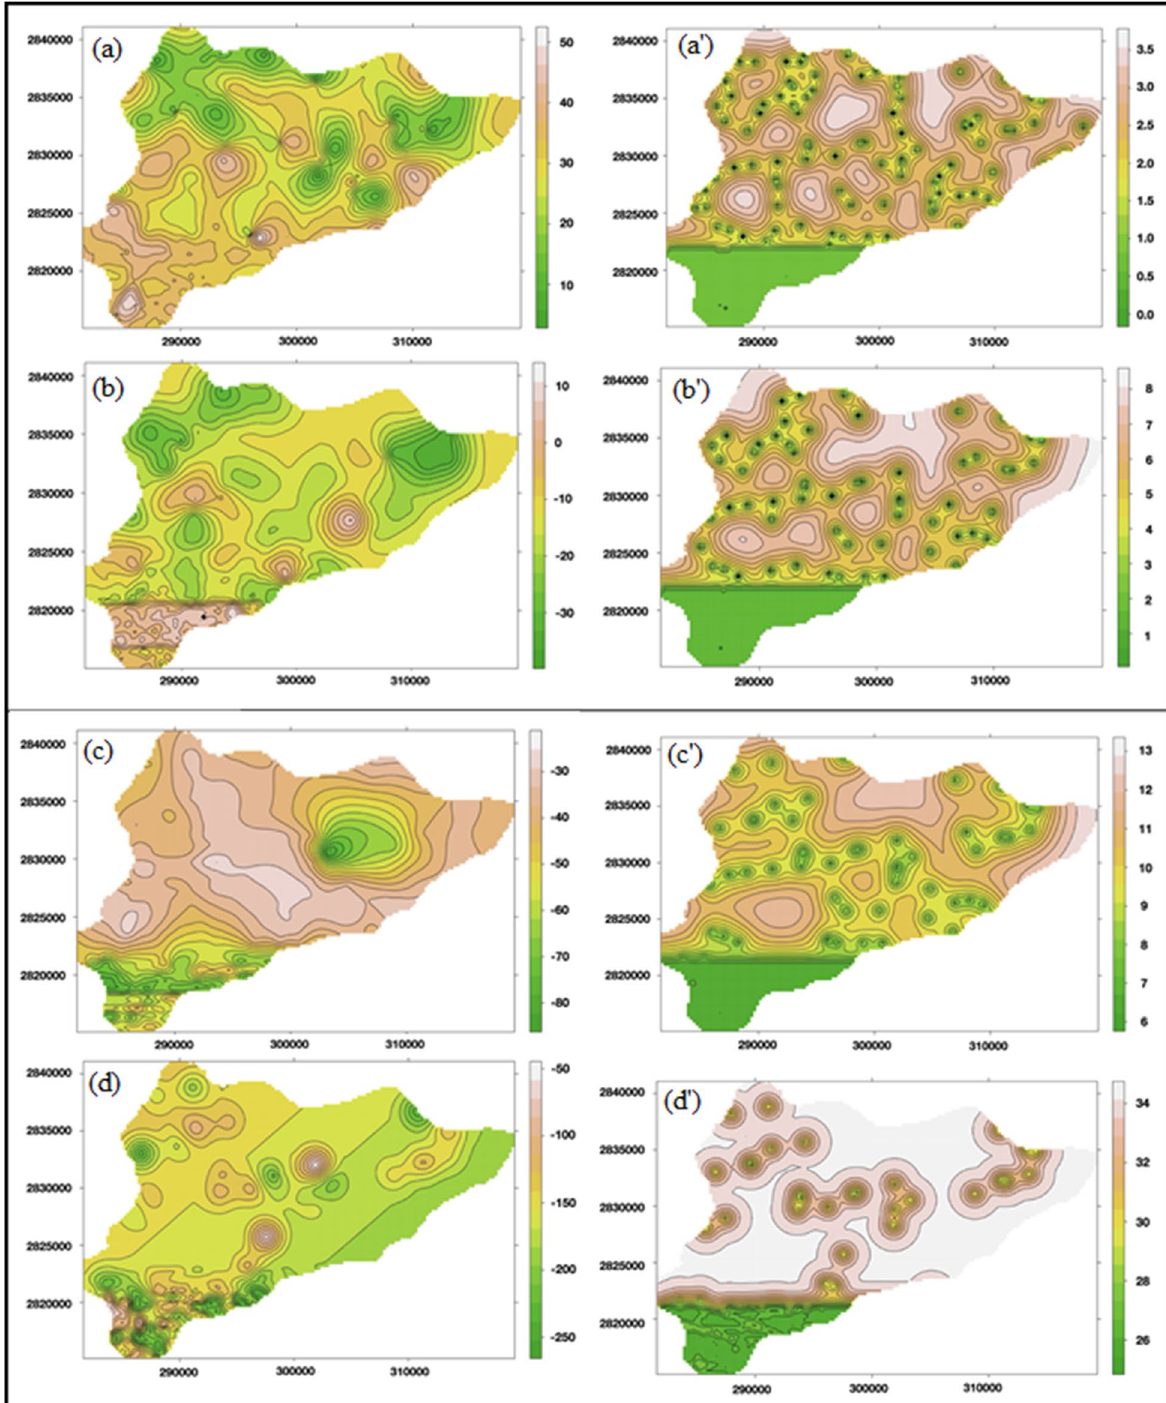
Figure 3. Predicated Z-values of ( a ) Z1, ( b ) Z2, ( c ) Z3, and ( d ) Z4 (in AMSL) corresponding their errors in the cases of ( a ′ ) Z1, ( b ′ ) Z2, ( c ′ ) Z3, and ( d ′ ) Z4 (in AMSL), respectively (J.D.: drawn this figure with the help of R Core Team (2013). R: A language and environment for statistical computing. R Foundation for Statistical Computing, Vienna, Austria, http:// www.R- proje ct.